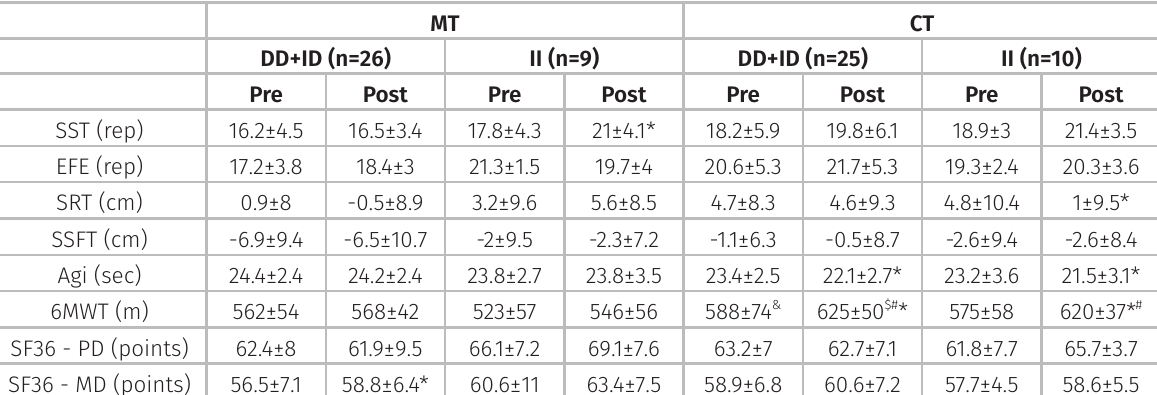
Table II. Physical capacities and quality of life of MT and CT groups related to ACE polymorphism.